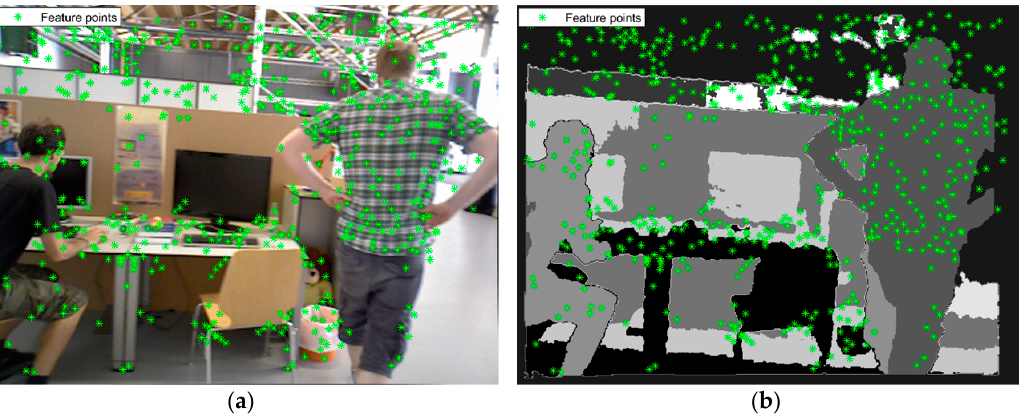
Figure 4. The first step of the moving object detection method. ( a ) Extraction and matching of point features; ( b ) clustering filled depth image. Different gray values in the clustered depth image represent different clusters.